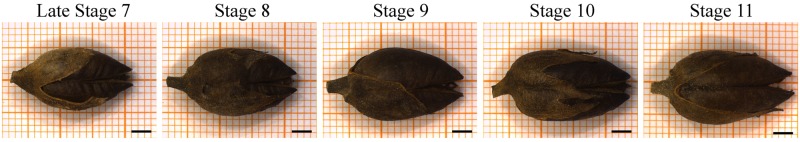
Representative fruits produced as a result of hand pollinations performed at different stages of Nicotiana tabacum flower development. There is a gradual increase in fruit size from late stage 7 to stage 11.